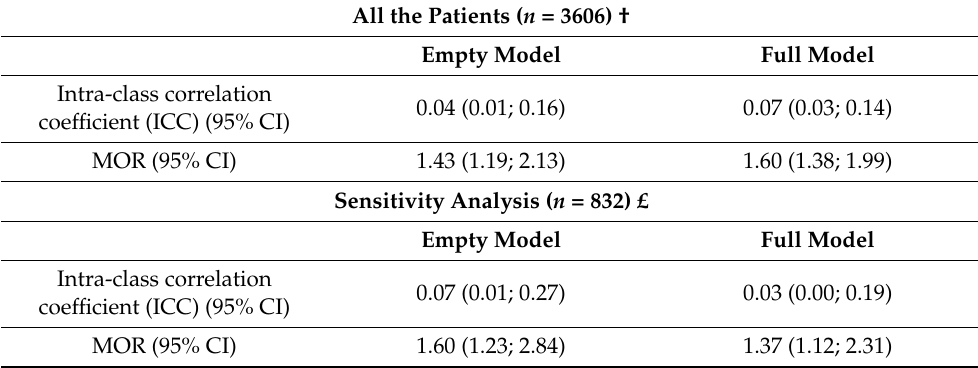
Table 4. Estimates of the inter-physician variability for improvement in referred pain